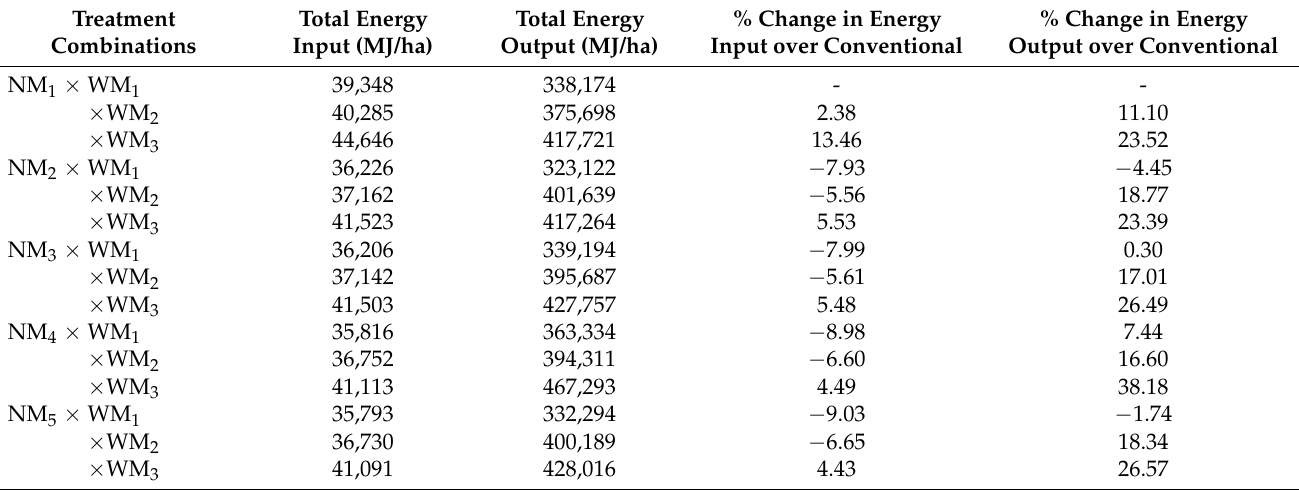
Table 10. Influence of management practices on change in energy input and output over conventional practices.